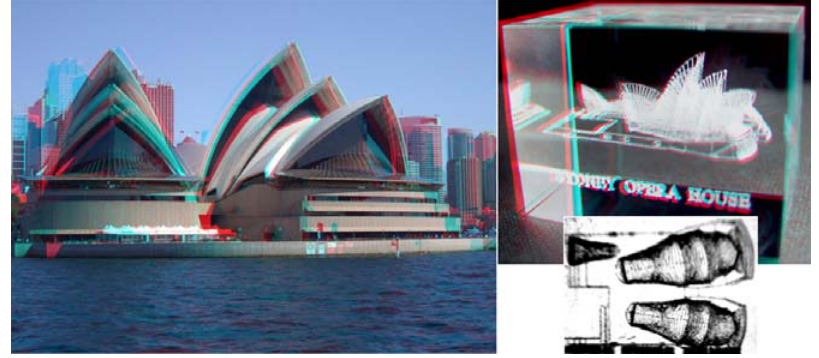
Figure 1. As a homage in 3D to the 23 rd ISPRS Congress in Melbourne color anaglyphs of the famous Sydney Opera (left) are presented in comparison with an “early bird” lasered crystal, including the plan projection (right; courtesy R.Titze of LOOXIS, Hannover; photographs by the authors, use color anaglyph